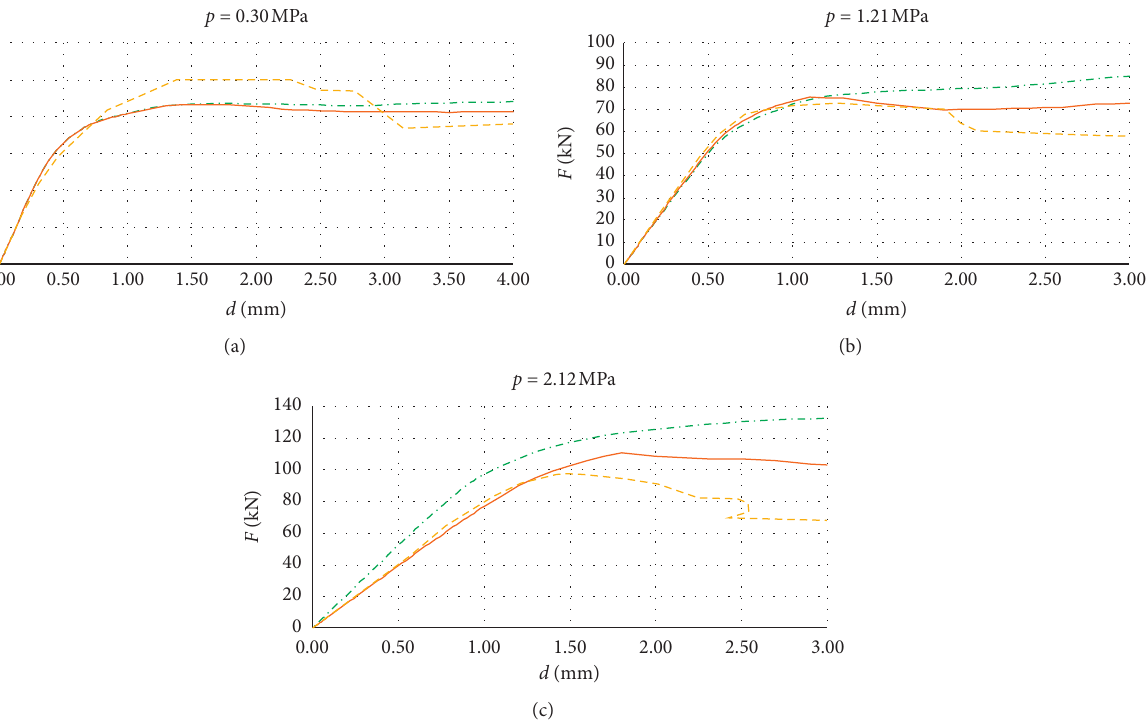
Figure 13: Pushover curves of the numerical shear tests with varying compression. Continuous line for refined rigid block model, dotted line for original rigid block model, and dashed line for laboratory test